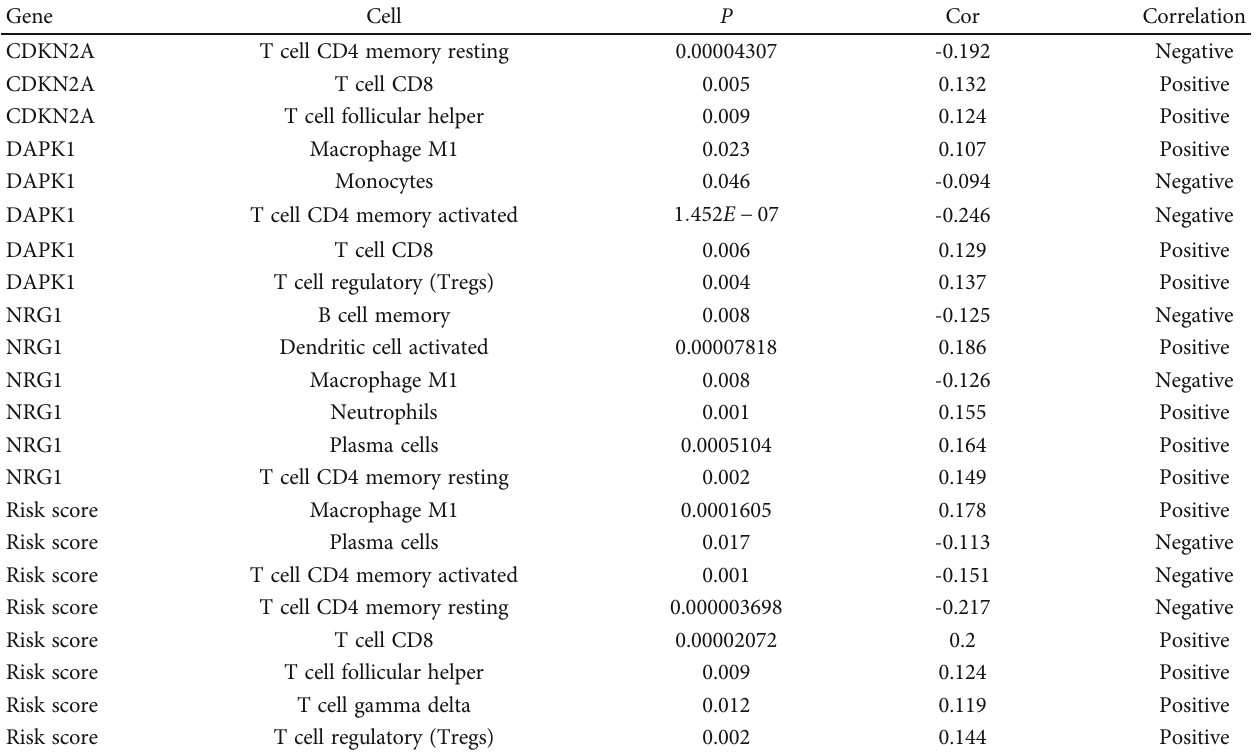
Table 3: The association between ARP hub signature expression and TII cell distribution in CRC patients ( P < 0 : 05 ). Gene Cell P CDKN2A T cell CD4 memory resting